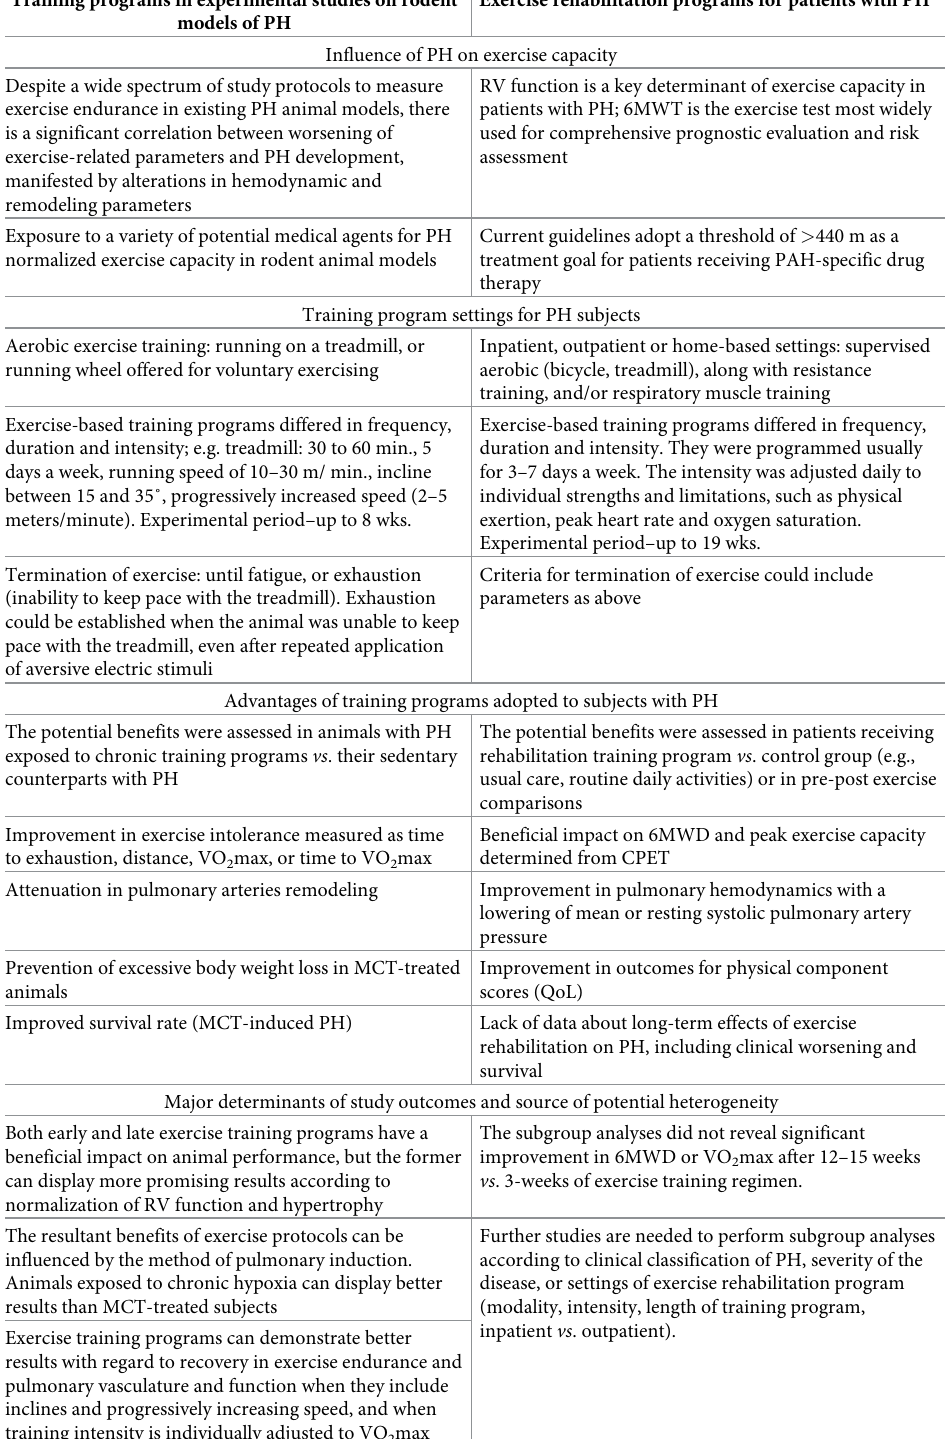
Table 2. A summary of the major outcomes from preclinical and clinical studies on exercise training regimens for subjects with PH. Training programs in experimental studies on rodent Exercise rehabilitation programs for patients with PH � models of PH Influence of PH on exercise